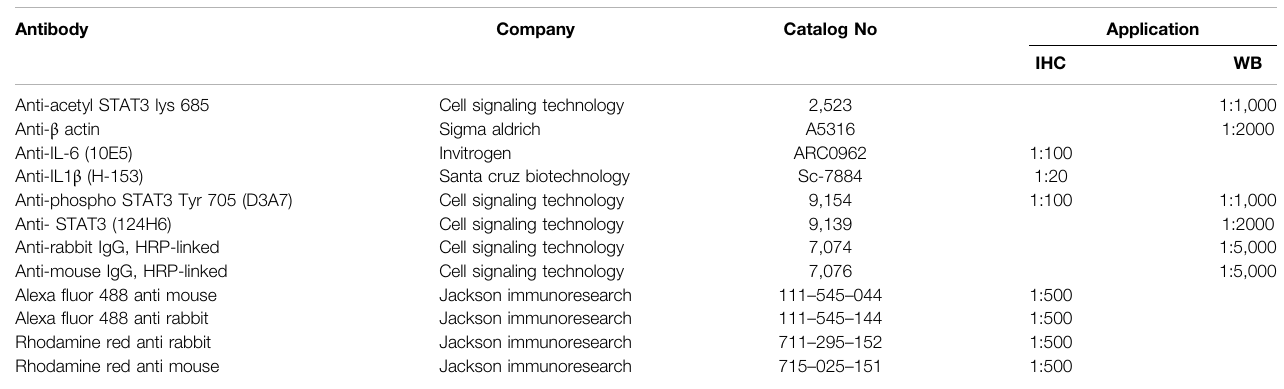
TABLE 2 | List of antibodies, vendors, catalog number, and dilutions used in the current study. Antibody